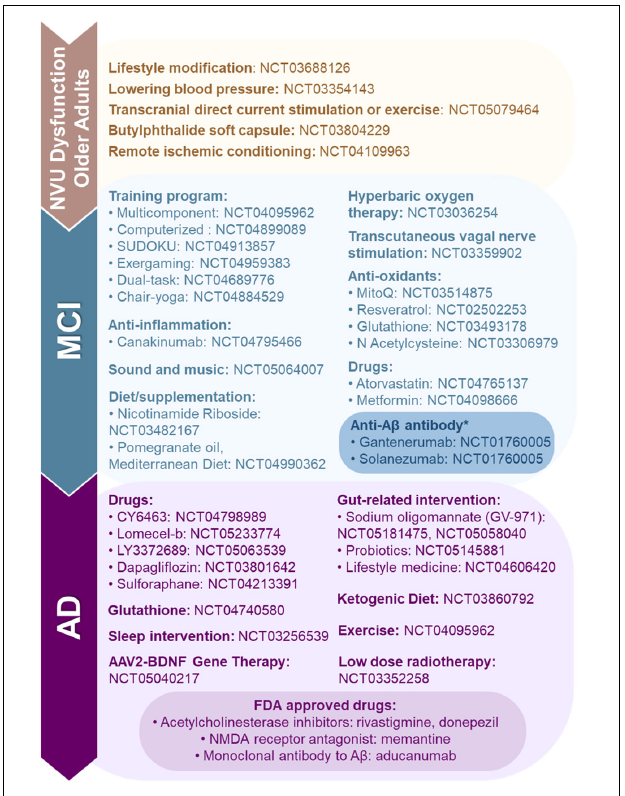
FIGURE 3 | Food and Drug Administration (FDA) approved, clinical trials and preclinical studies of neurovascular unit (NVU) dysfunction, mild-cognitive impairment (MCI) and Alzheimer’s disease (AD). Here, we highlight FDA approved drugs for AD, and ongoing preclinical studies and clinical trials targeting NVU dysfunction, MCI, and AD. *Clinical trials for anti-A β antibodies Gantenerumab and Solanezumab are being conducted in